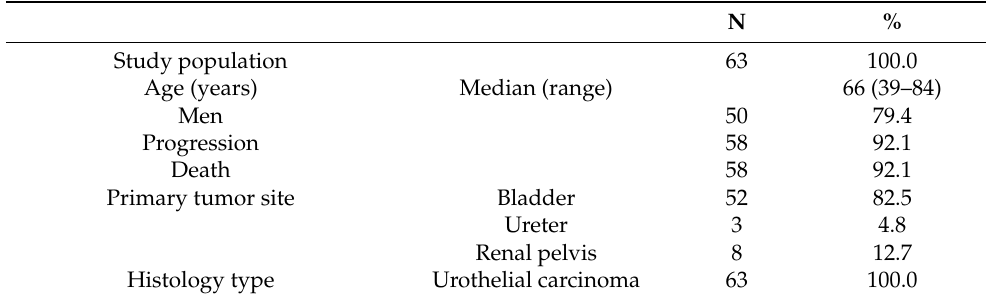
Table 6. Characteristics of study population. N: number of patients; CHT: chemotherapy; AEs: adverse events; GC: gemcitabine + cisplatin; ECOG: Eastern Cooperative Oncology Group; CR: complete response; PR: partial response; * at least one serious